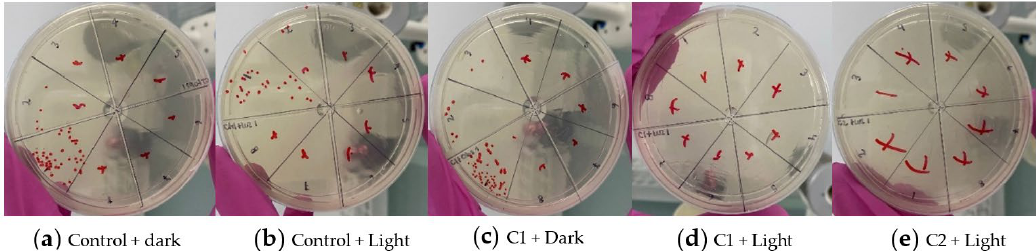
Figure 11. Antimicrobial effect of C1 and C2 nanocomposites at C. albicans in vitro. C1: GO-MNPs- VGLPEGDA- ZnMintPc, C2: MWCNT-MNPs-VGLPEGDA- ZnMintPc, C3: GO-MNPs- VGLPEGDA- ZnMintPc, C2: MWCNT-MNPs-VGLPEGDA- ZnMintPc, C3: GO-MNPs-VGLPEGDA, VGLPEGDA, C4: MWCNT-MNPs-VGLPEGDA. The concentration of MNPs in C1, C2, C3 and C4 C4: MWCNT-MNPs-VGLPEGDA. The concentration of MNPs in C1, C2, C3 and C4 was 93.3 µ g · mL − 1 was 93.3 μg ·mL −1 . The concentration of ZnMintPc in C1 and C2 was 8.1 μM . The concentration of